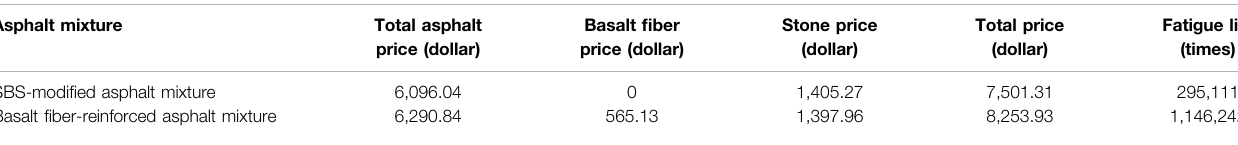
TABLE 10 | Economic